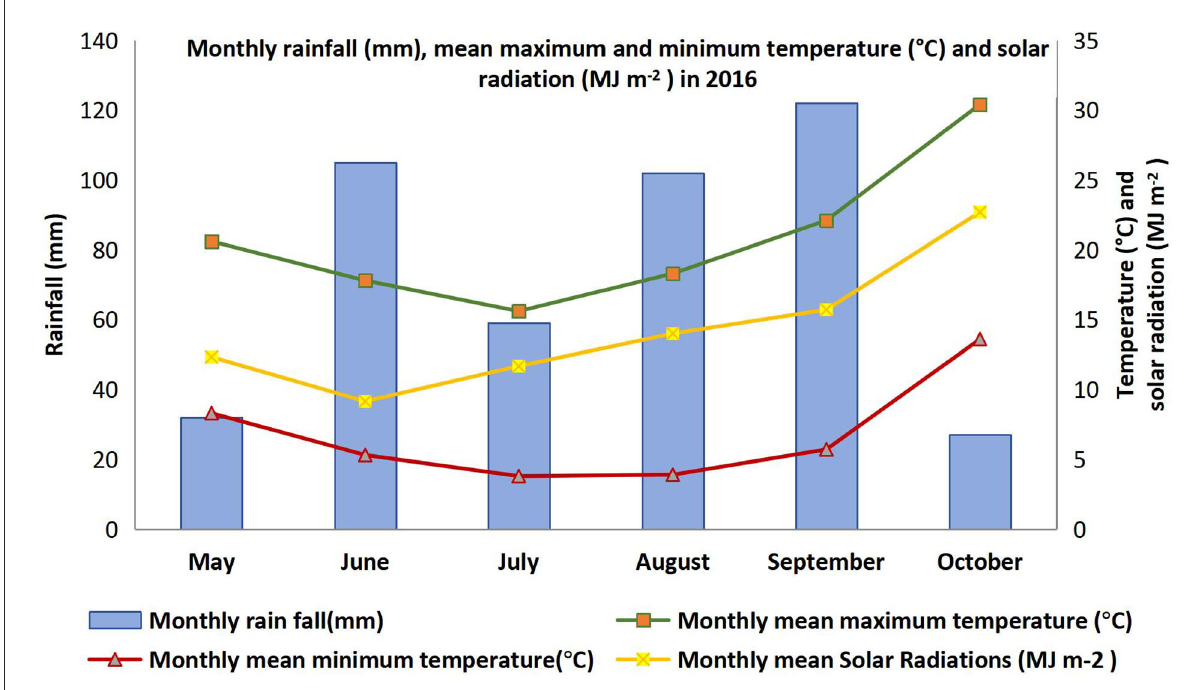
FIGURE1 Monthly rainfall (mm), mean maximum and minimum temperature ( ◦ C), and solar radiation (MJ m − 2 ) in 2016 at